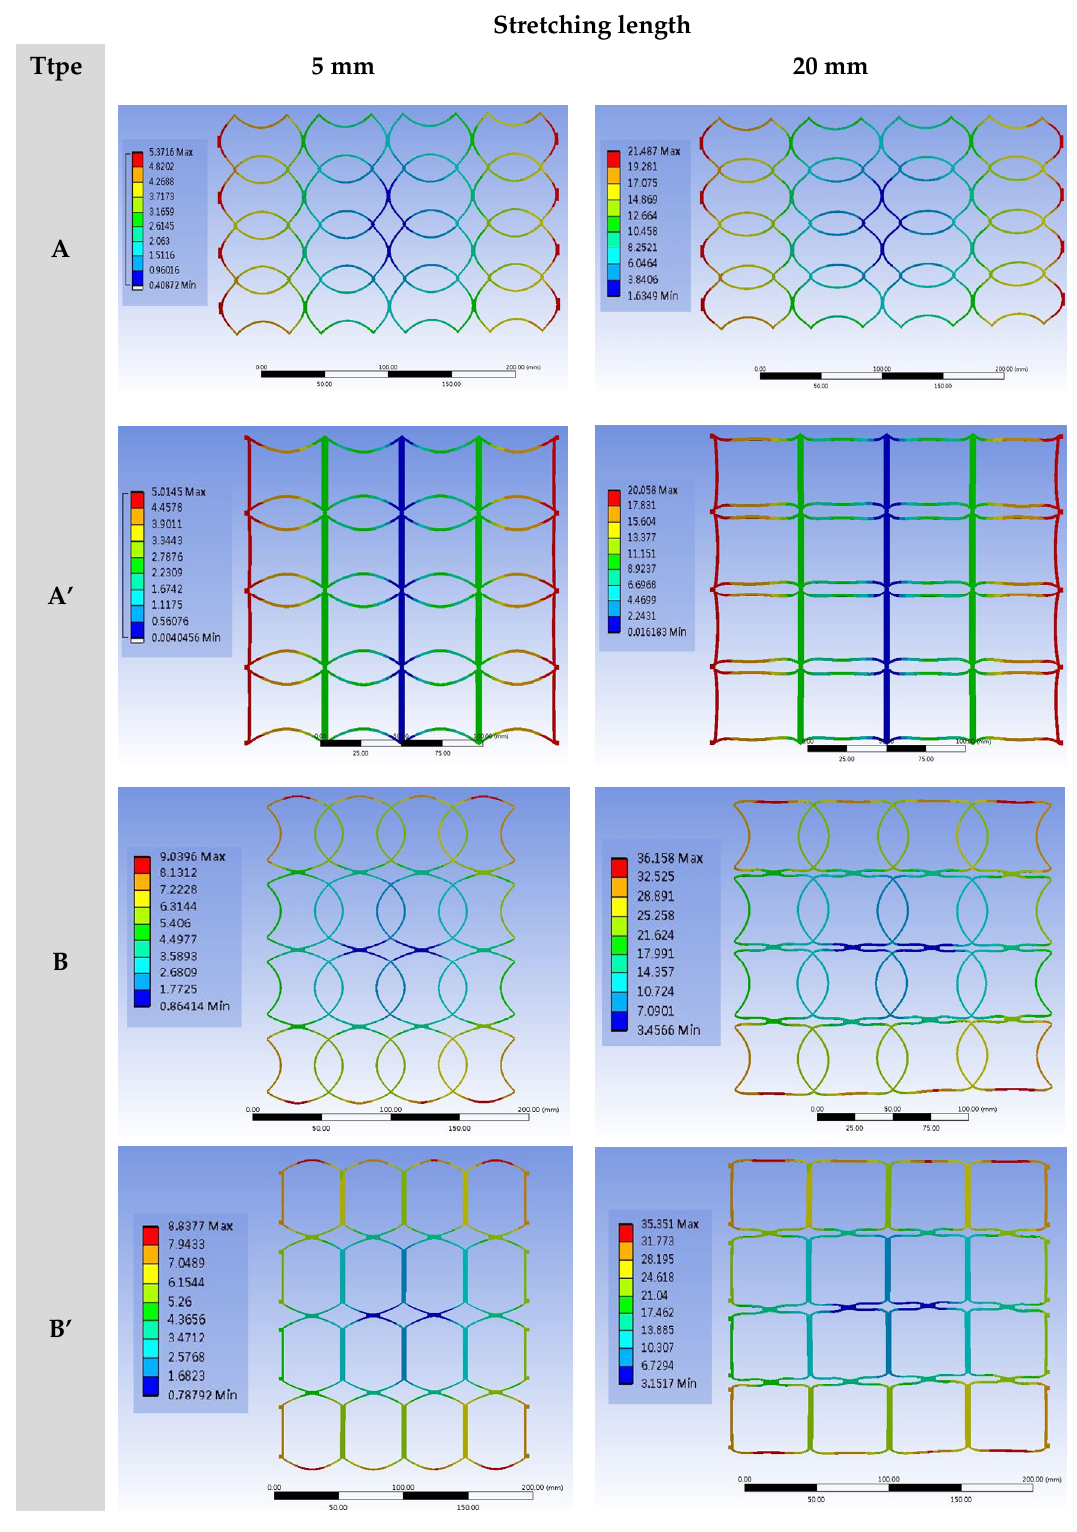
Figure 14. The basic SIN waveforms into four types for preliminary simula-tion analysis, and designed based on the results of software simulation, namely A-type, A’-type, B-type, and B’-type, and deformation simulation of 4 × 4 NPR arrays at different stretching lengths.